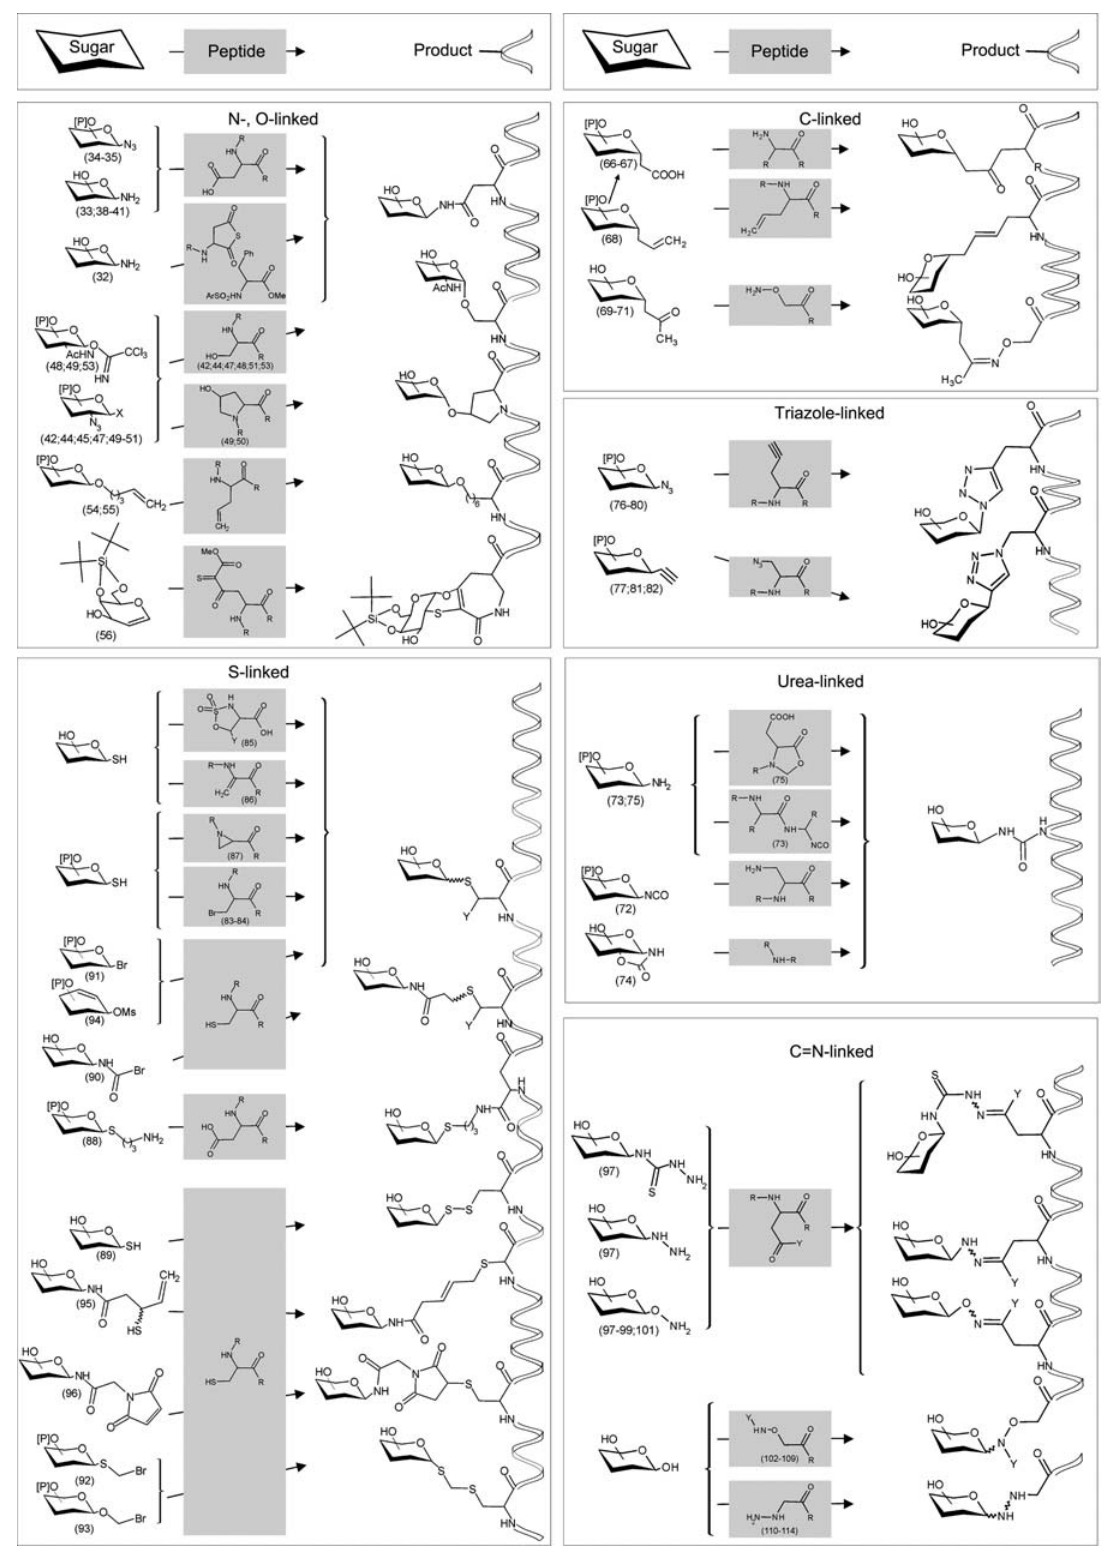
Figure 3 Synthetic chemistries for natural and non-natural glycoconjugate linkages. Chemistries are grouped according to the sugar-peptide linkage; top drawings indicate the direction of the reactions. P, protecting groups for sugar hydroxyls; R, protecting groups in the case of amino acids or remainder of the sequence in the case of peptides; X, bromine, chlorine, or thiophenyl; Y, proton or methyl. Numbers between parentheses correspond to